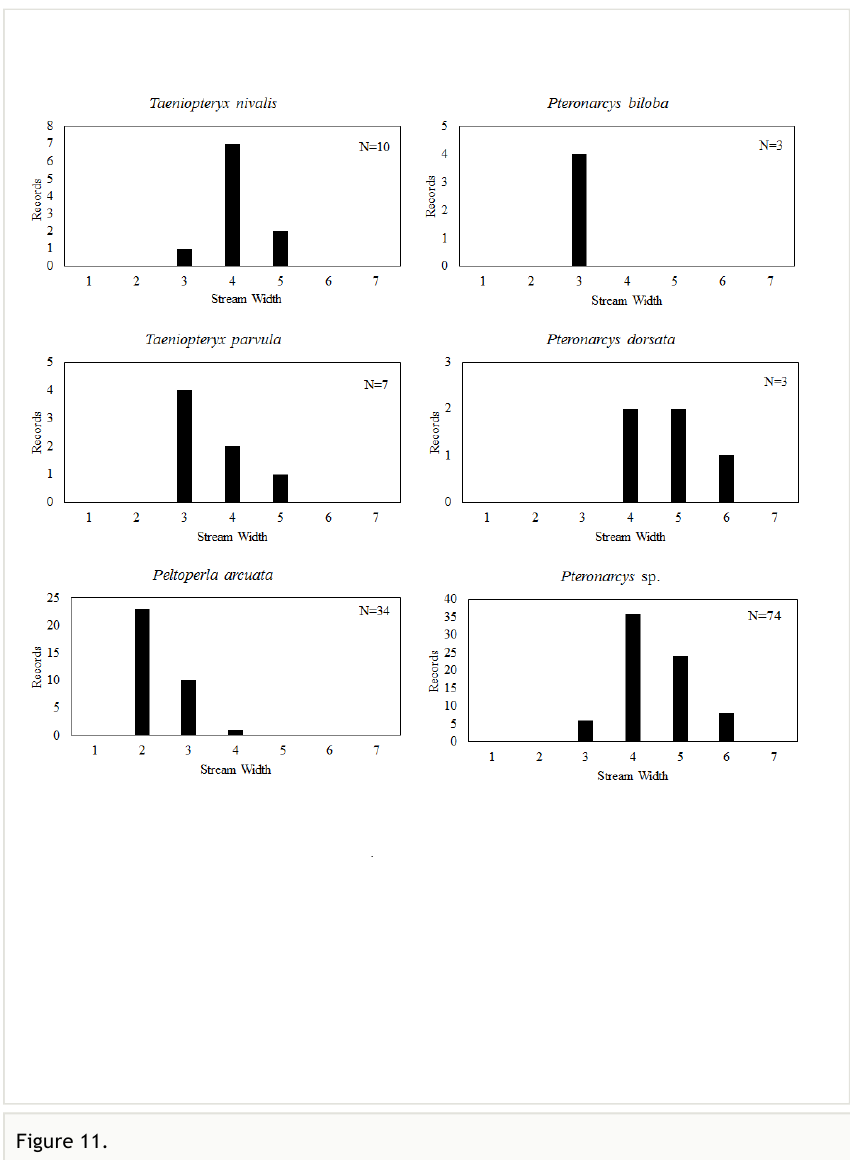
Figure 11. Stream width categories occupied by Taeniopterygidae, Peltoperlidae, and Pteronarcyidae species in Ohio. Stream width categories: 1=seep, 2=1-2 m, 3=3-10 m, 4=11=30 m, 5=31-60 m, 6=>60 m, 7=Lake